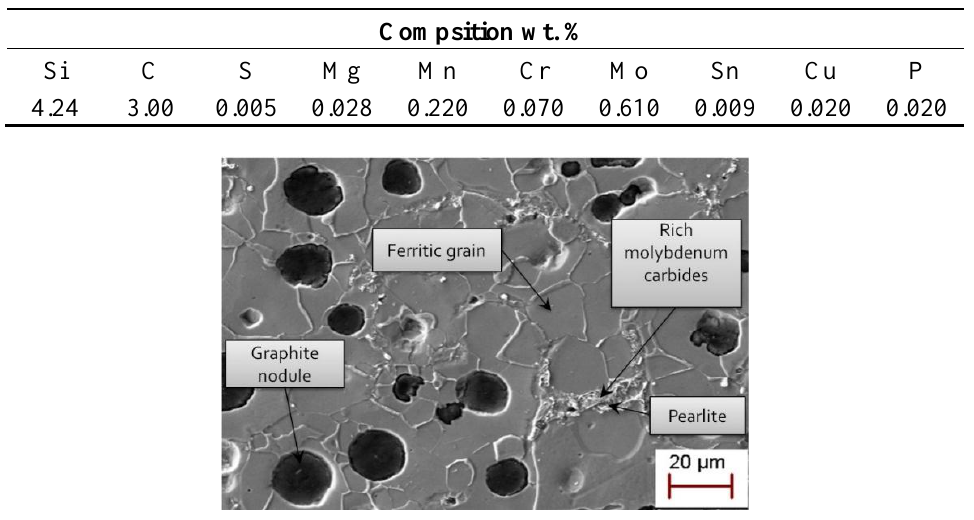
Figure 1. Typical initial microstructure of the studied ductile cast iron (DCI) (SEM observations). Mean grain size and crystallographic texture were obtained by electron back-scattered diffraction (EBSD, ZEISS, Marly le Roi, France) on electropolished samples. Samples exhibit a weak crystallographic texture [16], and the ferritic grain size follows a normal distribution with a mean value equal to 16 μm and a standard deviation of 4.4 μm. Nodule geometrical parameters ( i.e. , surface fraction, mean size diameter and aspect ratio) were obtained thanks to a numerical treatment of